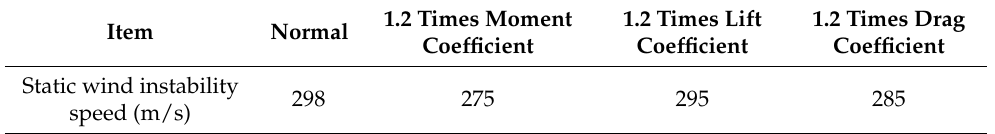
Table 2. Static instability wind speeds under different three-component force coefficients. Item Normal